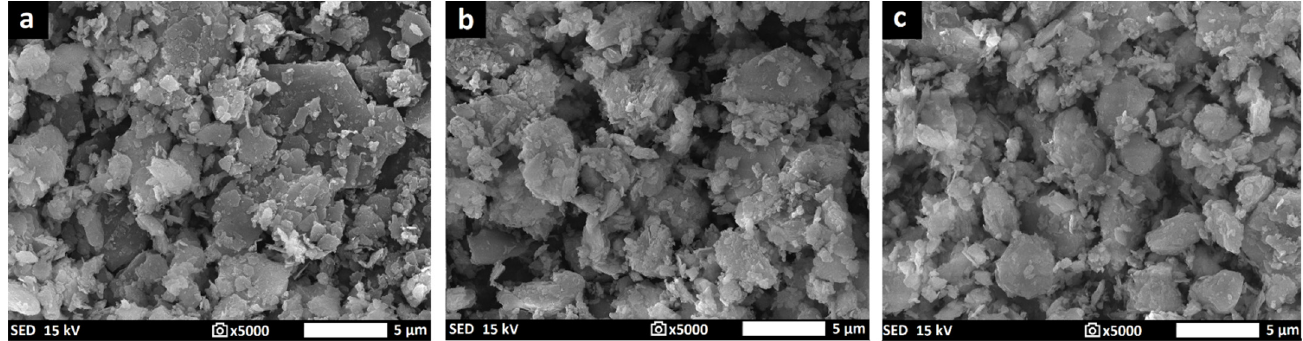
Figure 1. XRD patterns of the aluminosilicate raw materials ( a ) and chamotte ( b ).